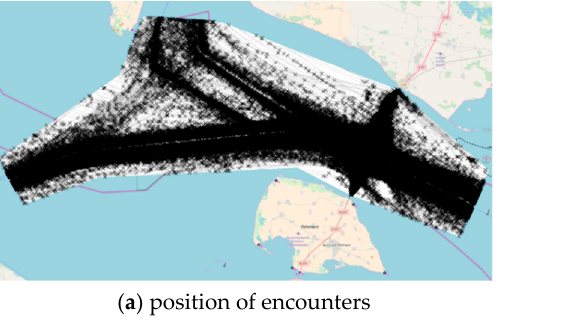
Figure 3. Encounters (marked with x) between pairs of vessels closer than 6 nm during March 2016 in the vicinity of Fehmarn: ( a ) position of encounters and ( b ) histogram of observed encounter distances.